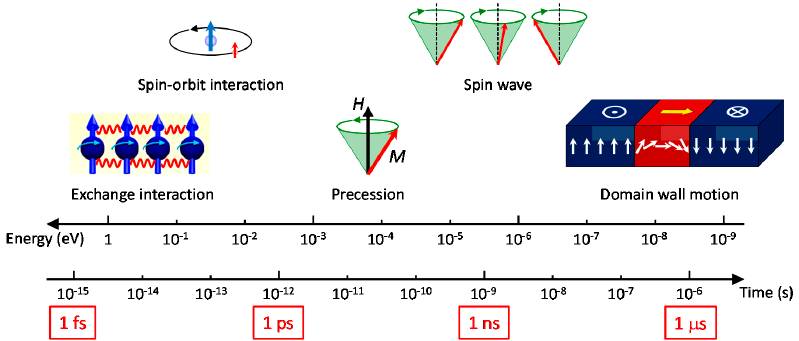
Figure 1. Characteristic energy and timescales of various magnetic phenomena. Timescales t are determined by the interaction energies E via the Heisenberg relation t = h / E ( t ( fs ) ∼ 4.13/ E ( eV )) . Here, h = 4.13 × 10 − 15 eV · s is Planck’s constant. The slowest dynamics is the domain-wall motion whose typical timescale is few ns to hundred µ s. Precession of magnetization occurs within 10–100 ps and gets damped in sub-ns to tens of ns. Thus, the spin waves in ferromagnetic materials can propagate within few hundreds of ps to tens of ns before it gets damped out. Elementary interactions in magnetism such as the spin-orbit interaction ( ∼ 10 fs–1 ps) and the exchange interaction ( ∼ 10 fs) are related to faster dynamics.